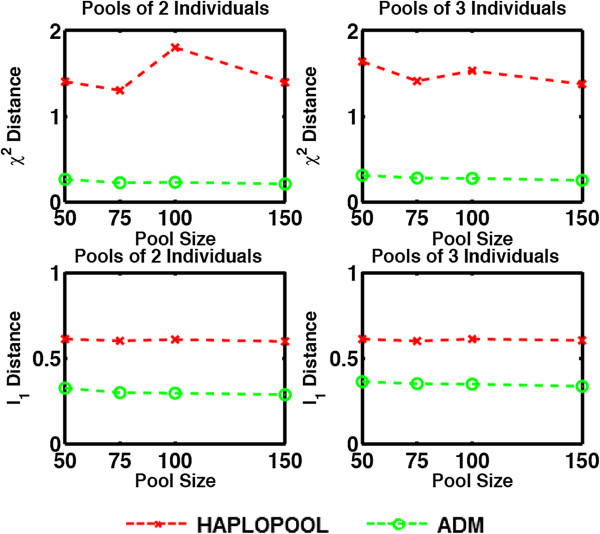
Measures of performance of HAPLOPOOL and ADM applied to the HapMap dataset.